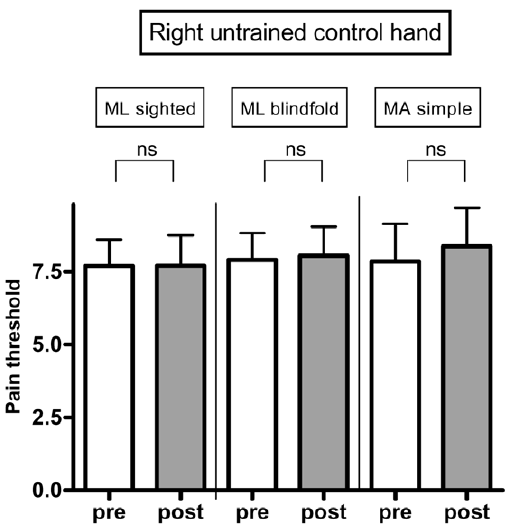
Figure 3. Results of pain thresholds: left hand. Pressure pain threshold levels before and after the tasks for the left trained hand. *=p , 0.05. **=p , 0.01. ***=p , 0.001.